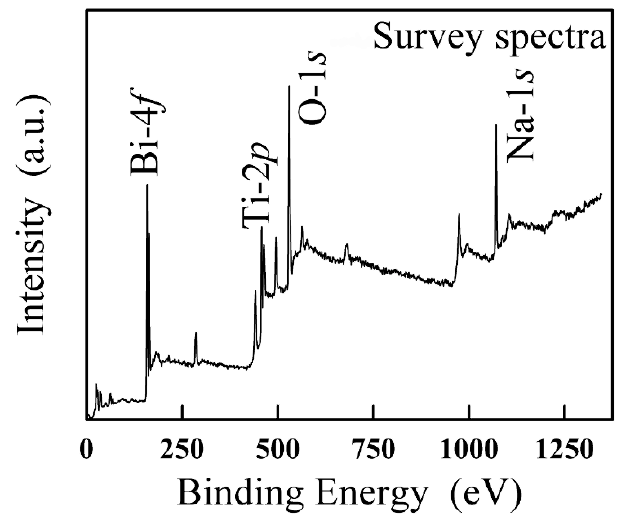
Figure 2. The XPS spectra of BNT.